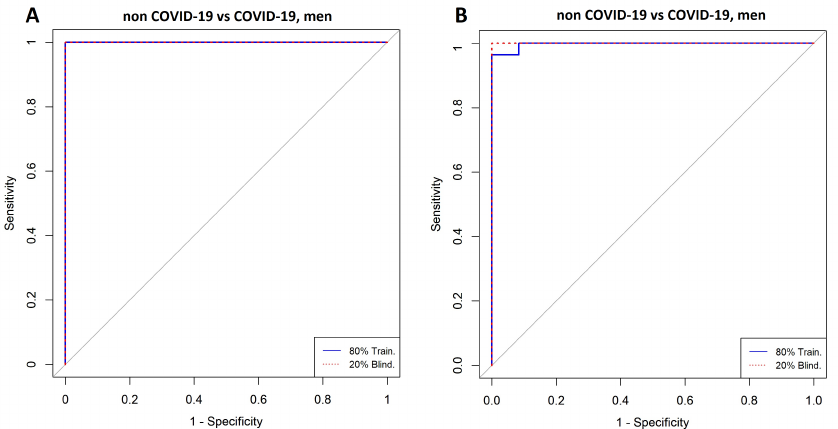
Figure 10. ROC curves for the classification of men with COVID-19 vs. men without COVID-19. ( A ) Logistic Regression and ( B ) Support Vector Machine. Model A was built with C10:1, kynure- nine/tryptophan, cough, lysoPC a 26:1, C10, lysoPC a C14:0, lymphocytes, and kynurenine. Model B was built with cough, lysoPC a C14:0, C10:1, and PC aa C40:2. Table 4. Evaluation criteria for logistic regression model with all factors and support vector machine for men with COVID-19 vs. men without